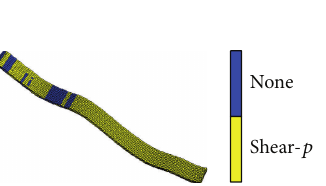
Figure 13: Plastic state of the sliding mass.